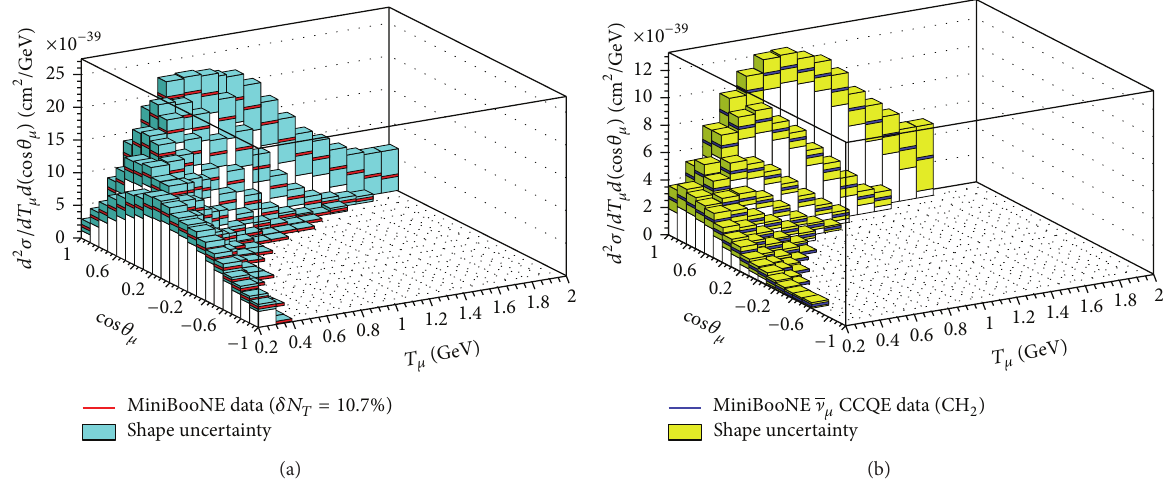
Figure 3: (Color online) MiniBooNE CCQE cross sections. (a) shows the muon neutrino flux-integrated CCQE double differential cross section on a neutron target. (b) shows muon antineutrino flux integrated CCQE double differential cross section on a CH 2 molecule.